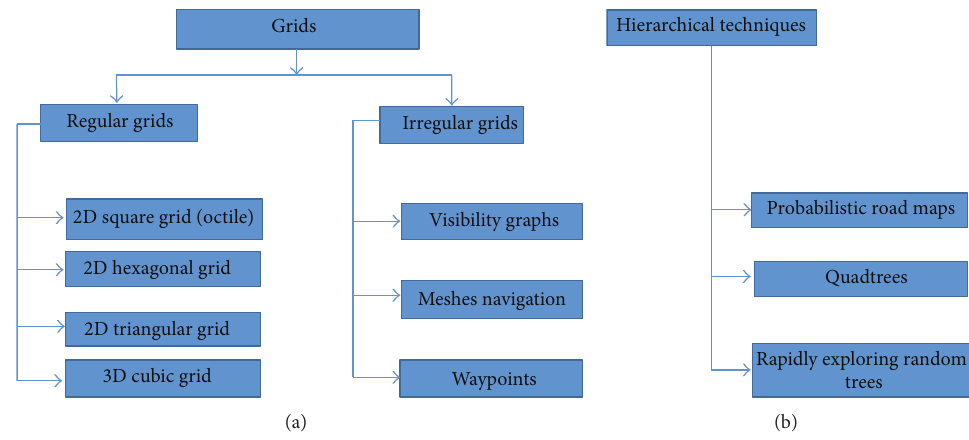
Figure 1: From left to right: (a) terrain topologies; (b) hierarchical